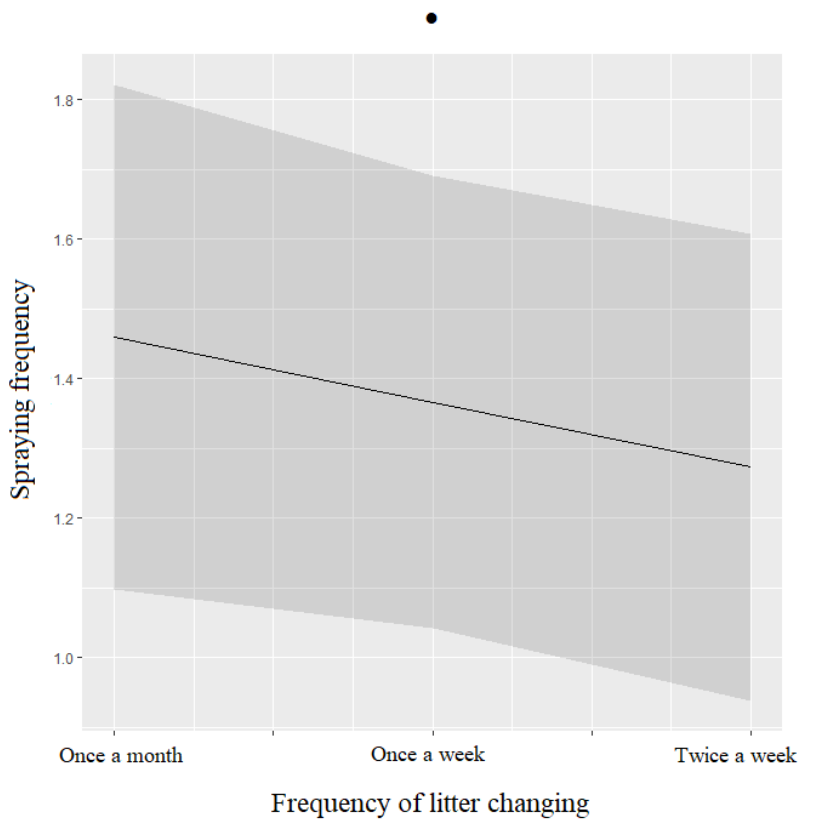
Figure 9. Means and 95% confidence intervals of cats’ spraying frequency depending on the frequency of litter changing, extracted from ordinal logistic regression: • : p < 0.10, Wald chi-squared test.